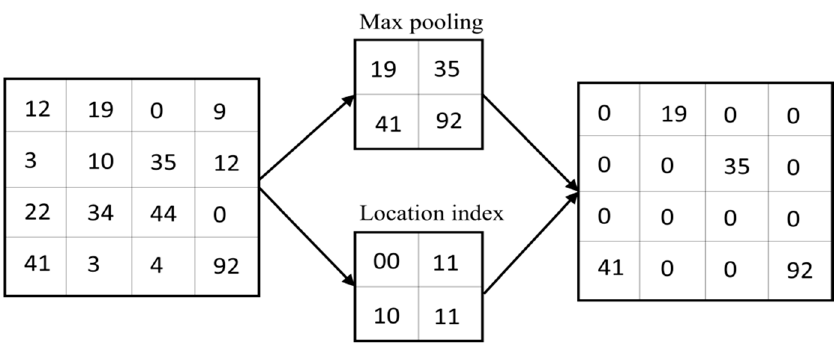
Figure 7. Pooling and unpooling for semantic segmentation.